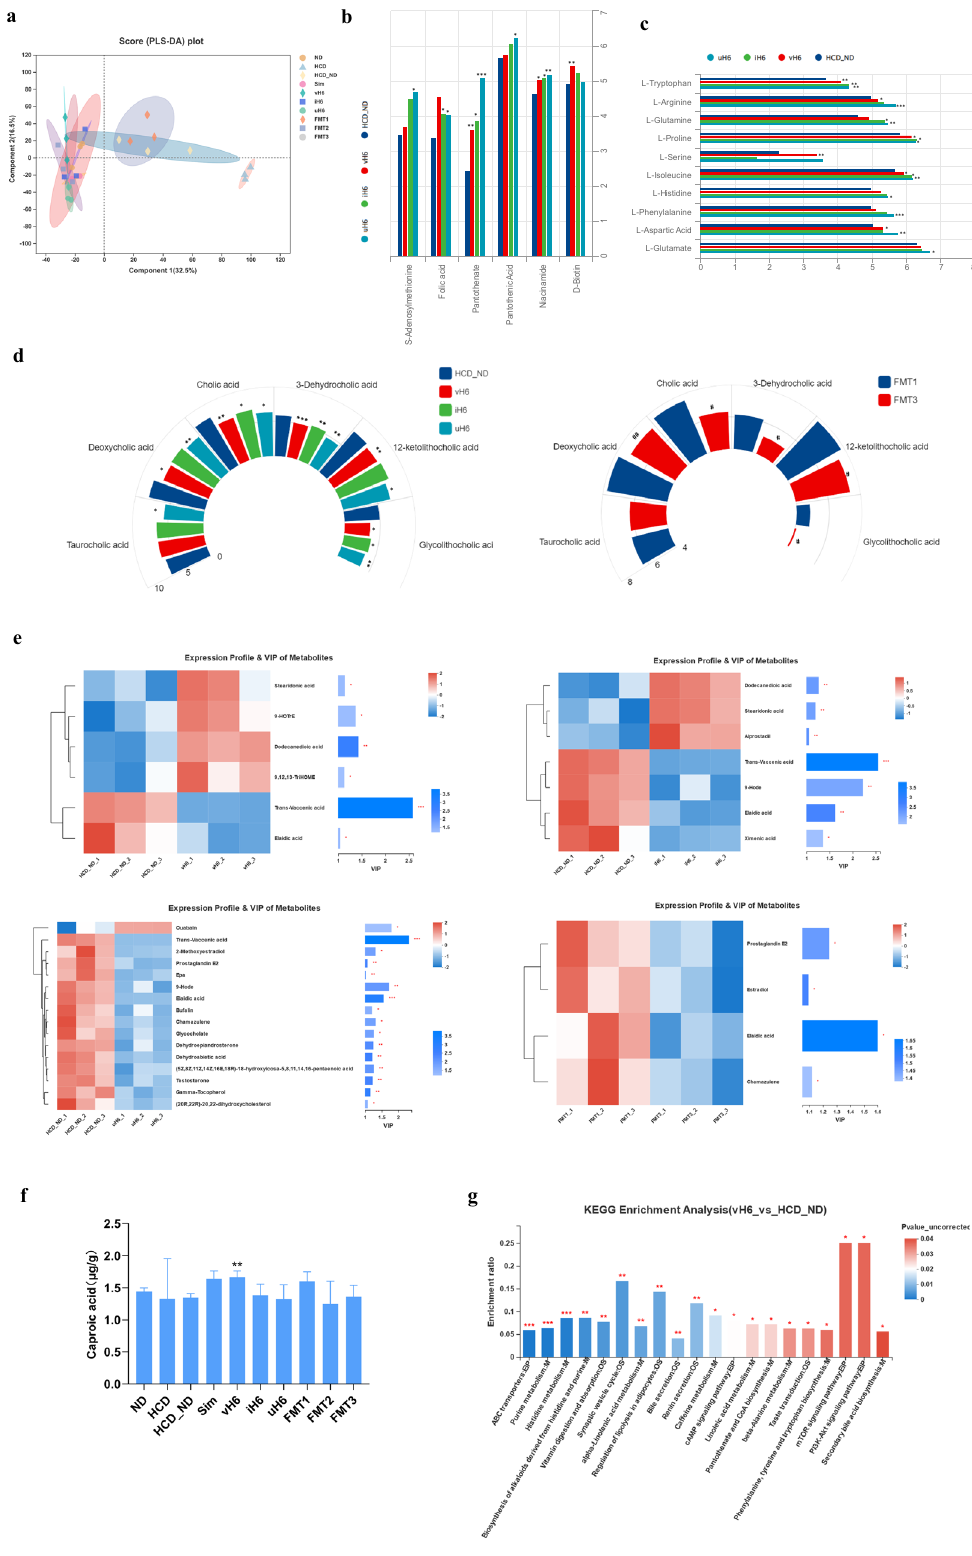
dominant bacteria (Fig. 6c). For bile acids, glycolithocholic acid had no correlation with unclassi fi ed_o__Bacteroidales and Turici- bacter . Romboutsia and Faecalibaculum showed signi fi cant posi- tive correlations with most bile acids (Fig. 6d). These